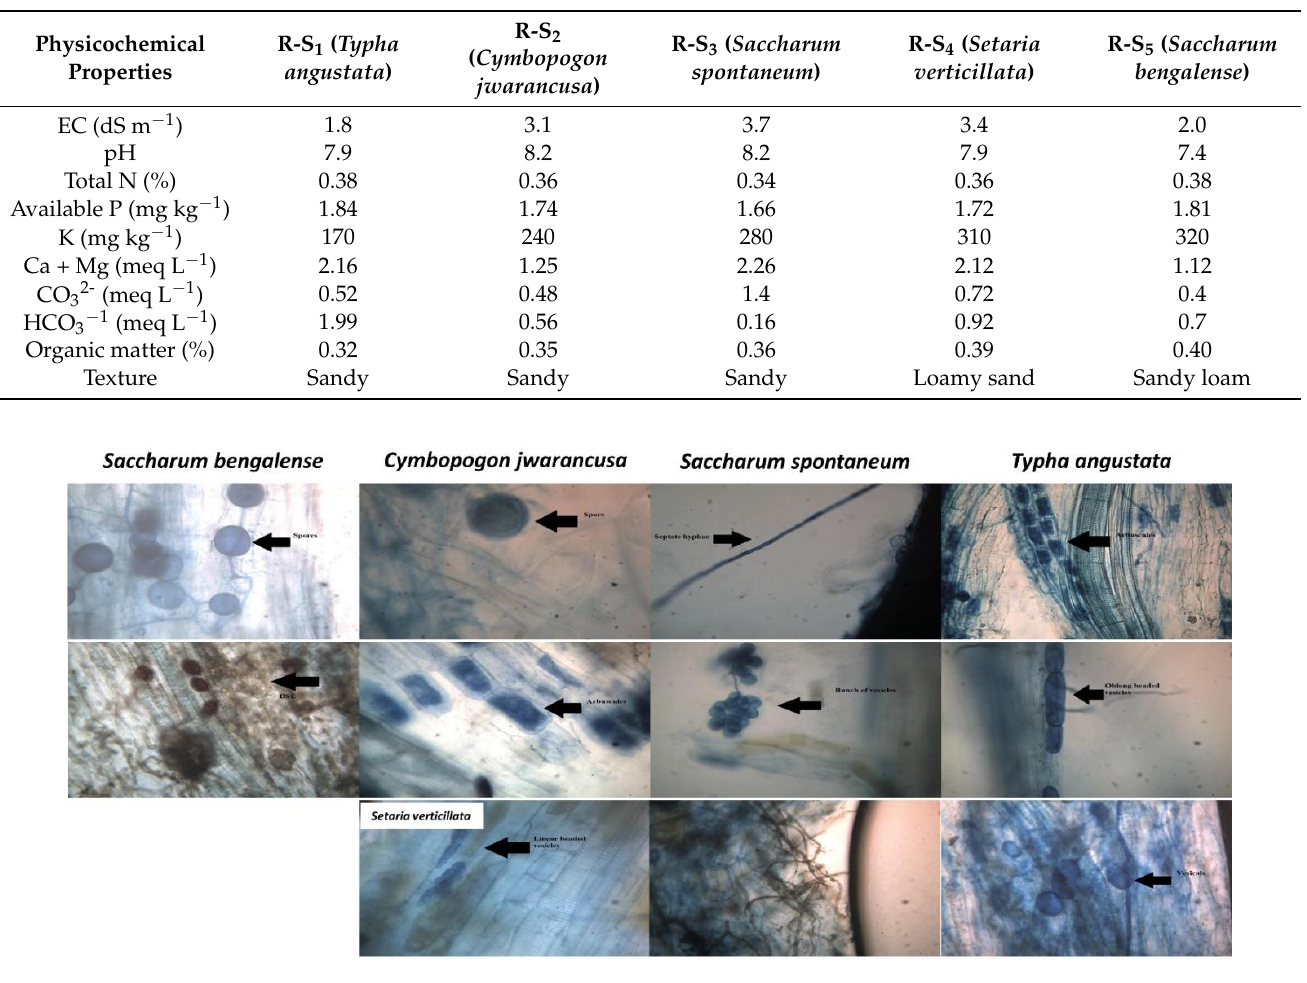
Figure 1. Hyphae, vesicles, spores, arbuscules, DSE, and ECM observed in the soil collected from the rhizospheric samples of different grasses.